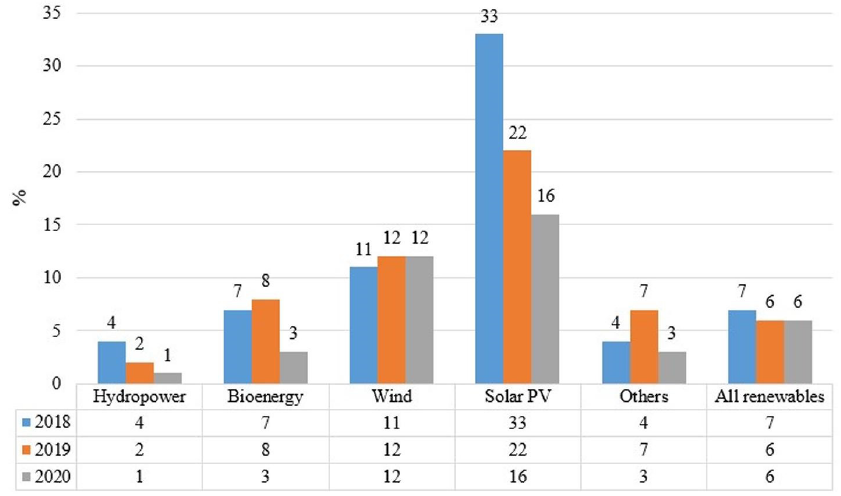
Figure 2. Annual growth of renewable electricity generation by source, 2018–2020. Source: developed by the authors based on [17,37,38].